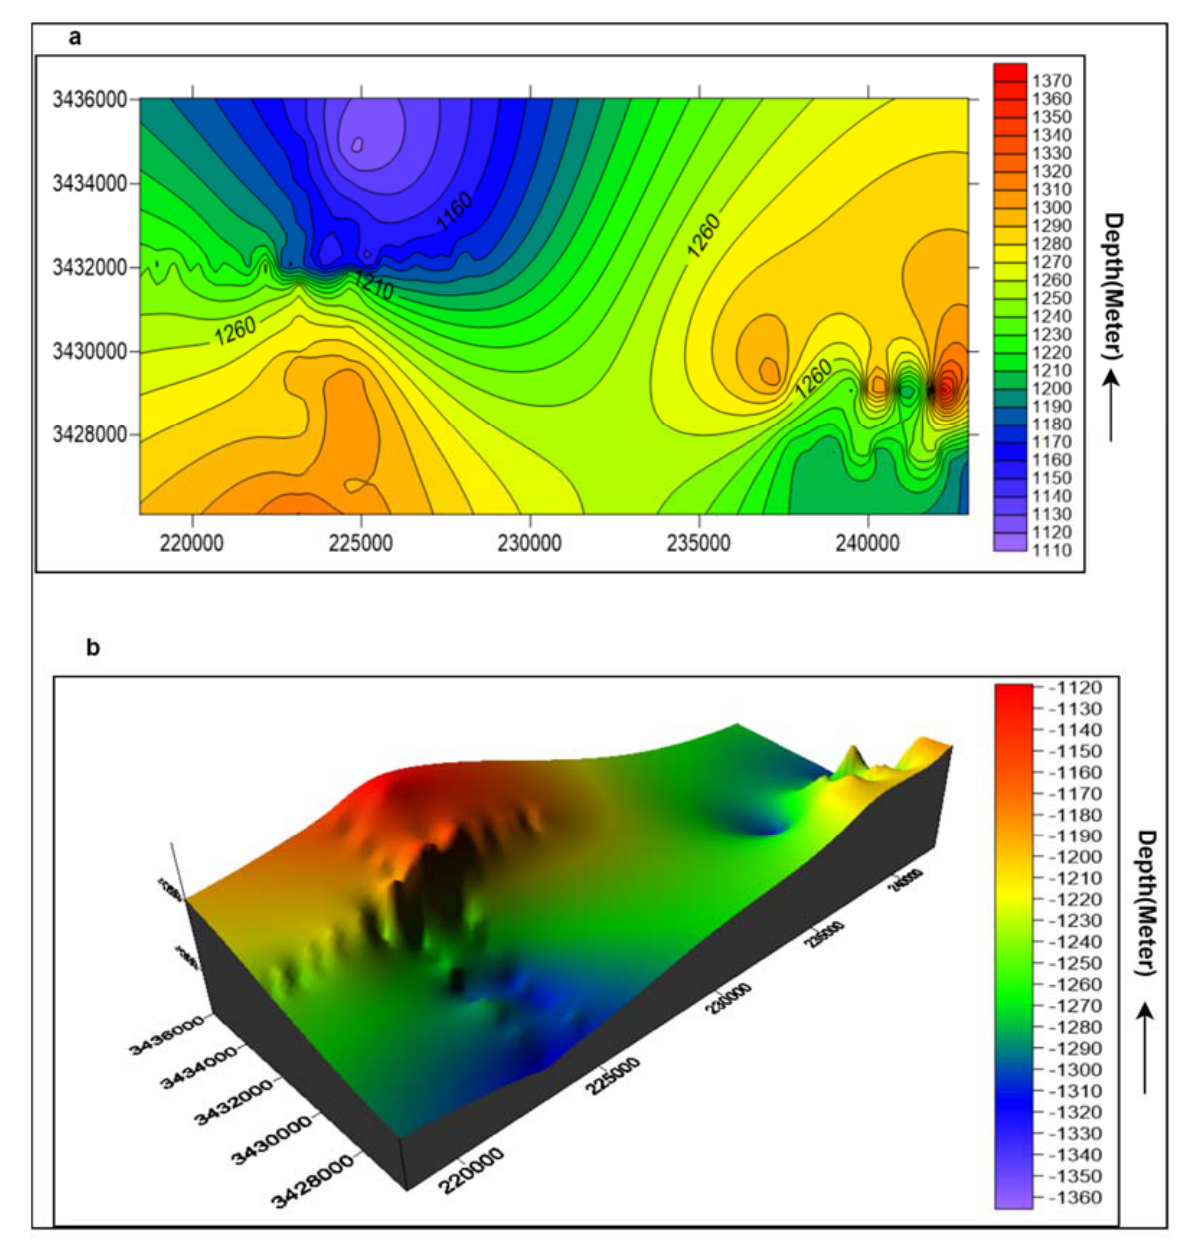
Figure 13. ( a ) Depth contour map of the Samana Suk formation. ( b ) Depth surface map of the Samana Suk formation. Figure 13 . ( a ). Depth contour map of the Samana Suk formation. ( b ). Depth surface map of the Samana Suk formation. The depth contour map of the Datta formation uses a similar template as the Samana Suk formation. The inclusive structure is the monocline structure of the Punjab platform, even though fluctuating variations in depth are shown. The decrease in depth value is from 1660 to 1320 m, as shown in Figure 14a. The depth contour surface of the Datta formation was generated by joining the points of equal depth. These depth values were assigned a color bar, which can be used as a guide for interpretation. On the color bar, red shows the shallowest point and purple-blue shows the deepest point (Figure